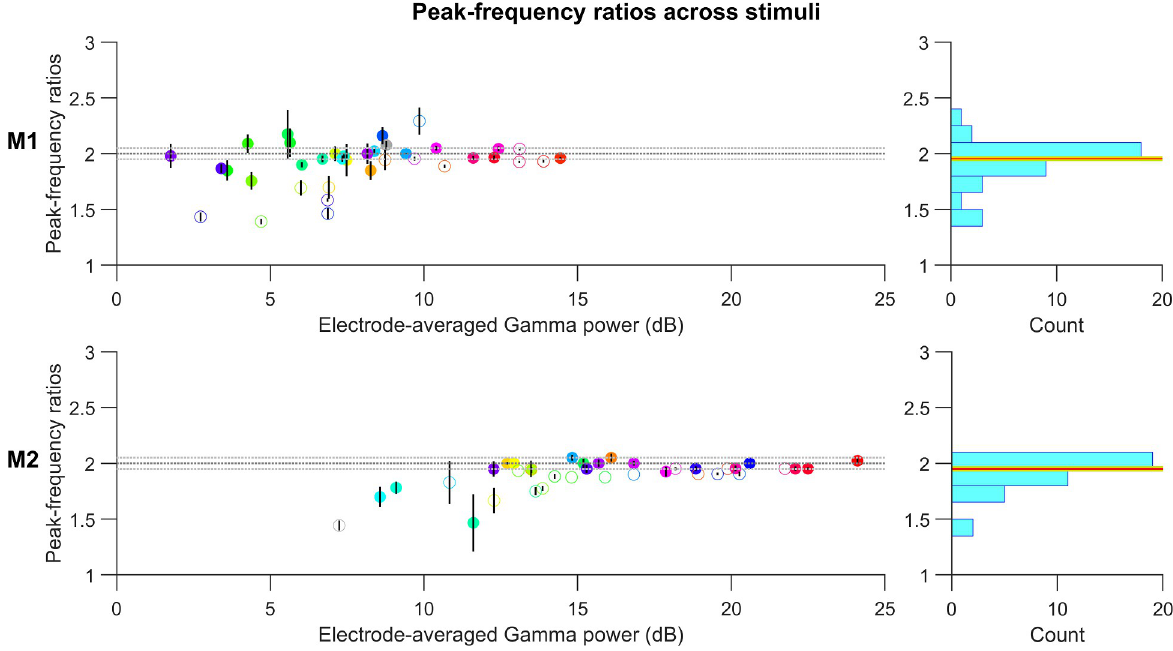
Fig 2. Second bump in PSD corresponds to the first harmonic of gamma. Median of peak frequency ratios of the second bump with respect to the gamma band, scattered against average gamma power for each stimulus (circles are colored to represent the presented hues; grating stimulus is represented by the grey circle). Error bars indicate the standard error of median (estimated by bootstrapping). Open circles mark stimuli whose ratios were found to be significantly different from 2 (p-value < 0.01 without any Bonferroni correction; Wilcoxon signed-rank test). The dotted horizontal lines correspond to the least-error margin 2 ± 0.05. The histograms on the right show the distribution of the median peak frequency ratios across all stimuli. The median ± 1SE computed for this distribution are represented by the red and yellow horizontal lines respectively.